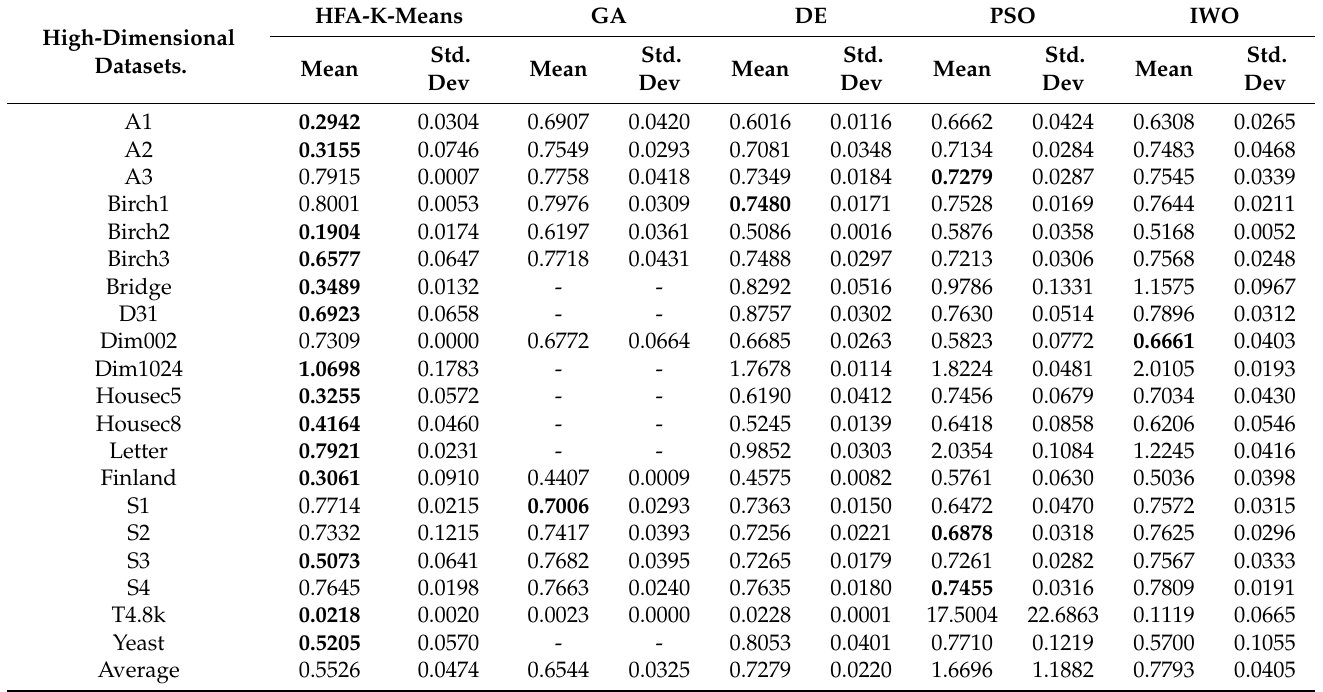
Table 7. Comparison of HFA-K-means with GA, DE, PSO, and IWO on twenty datasets.